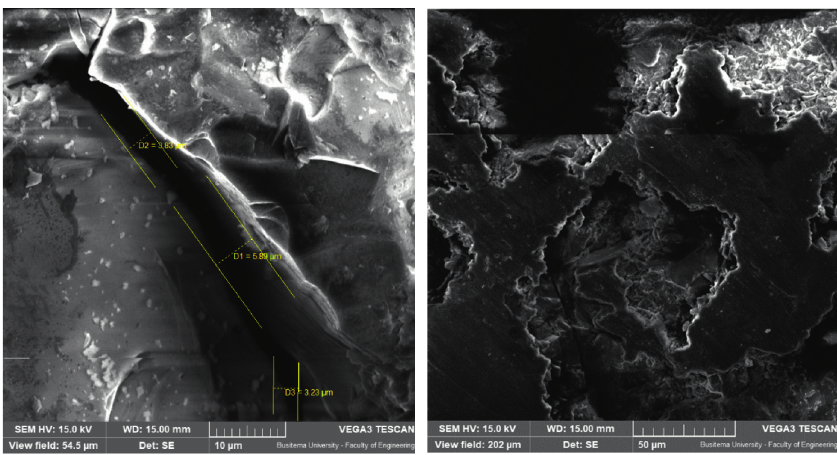
Figure 13: SEM morphology for banana fibre-reinforced concrete